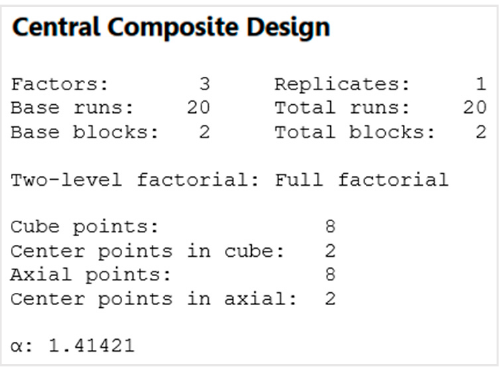
Table 5. Central composite design (one continuous factor and two categorical factors).